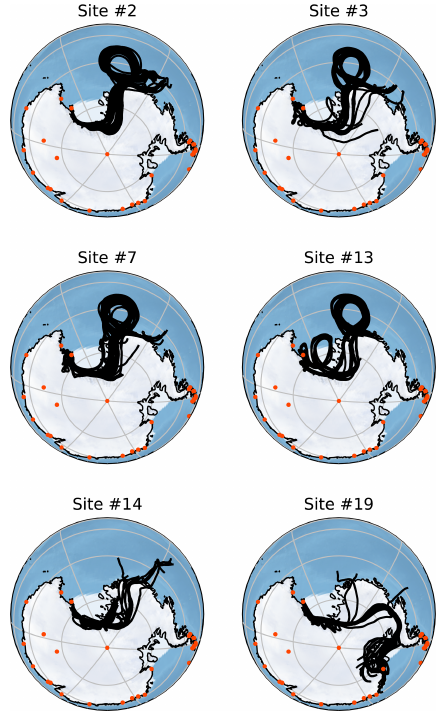
Figure A2. Like Fig. 5 but trajectories were initialized with a start- ing height of